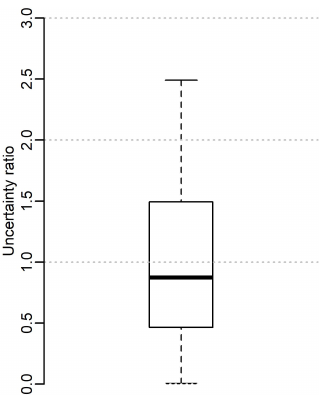
Figure 5. Box and whisker plots displaying the ratio of (1) the un- certainties of the spatial aggregate of the weighted product com- puted in sample to (2) the uncertainties of the spatial aggregate of the weighted product computed out of